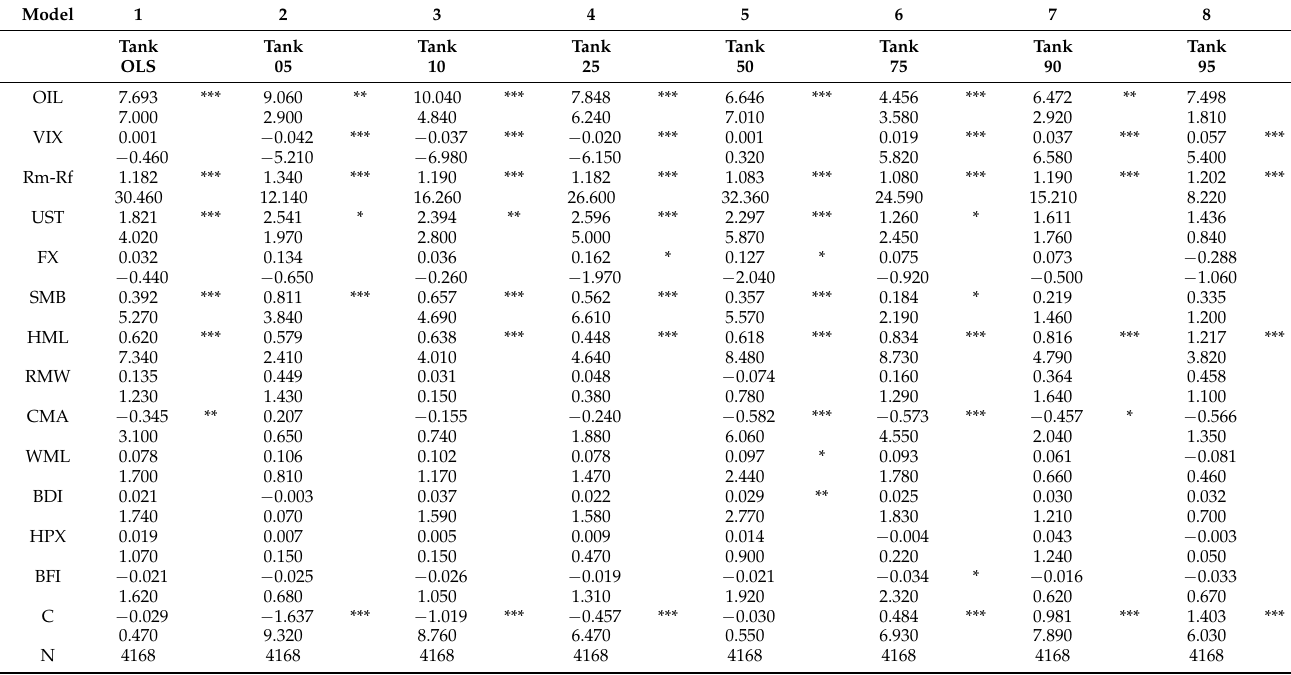
Table 4. Ordinary least square (OLS) and quantile regression estimates for the tanker segment.